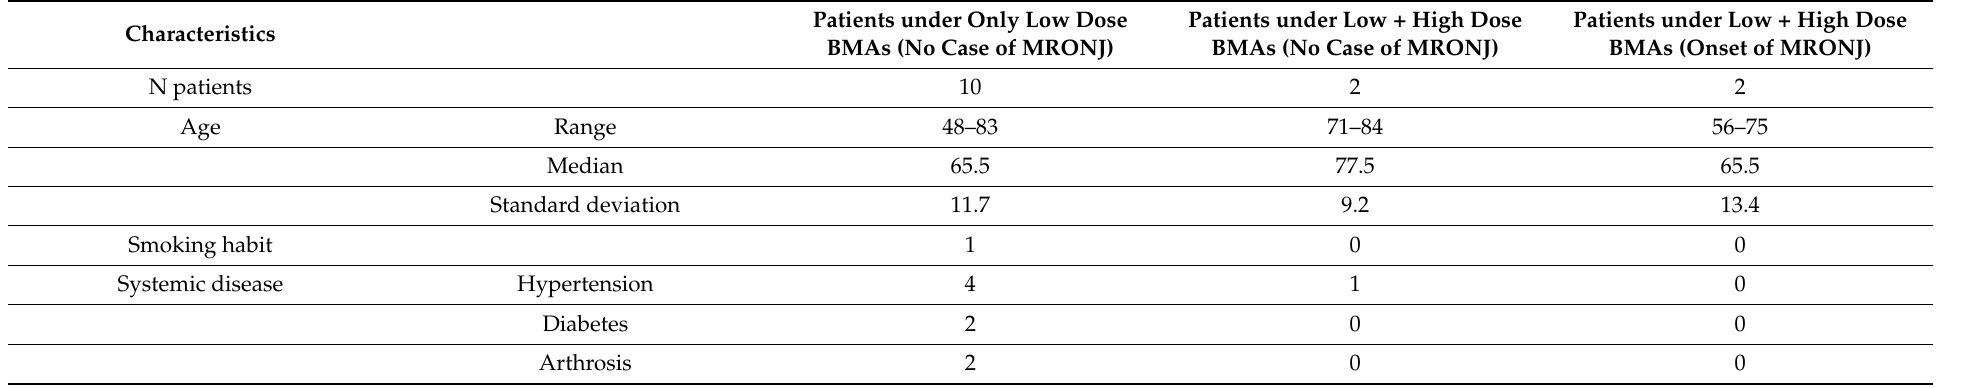
Table 4. Differences between BC patients’